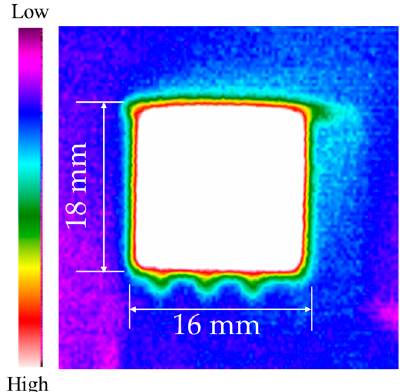
Figure 8. Infrared thermal image of thermal distribution.